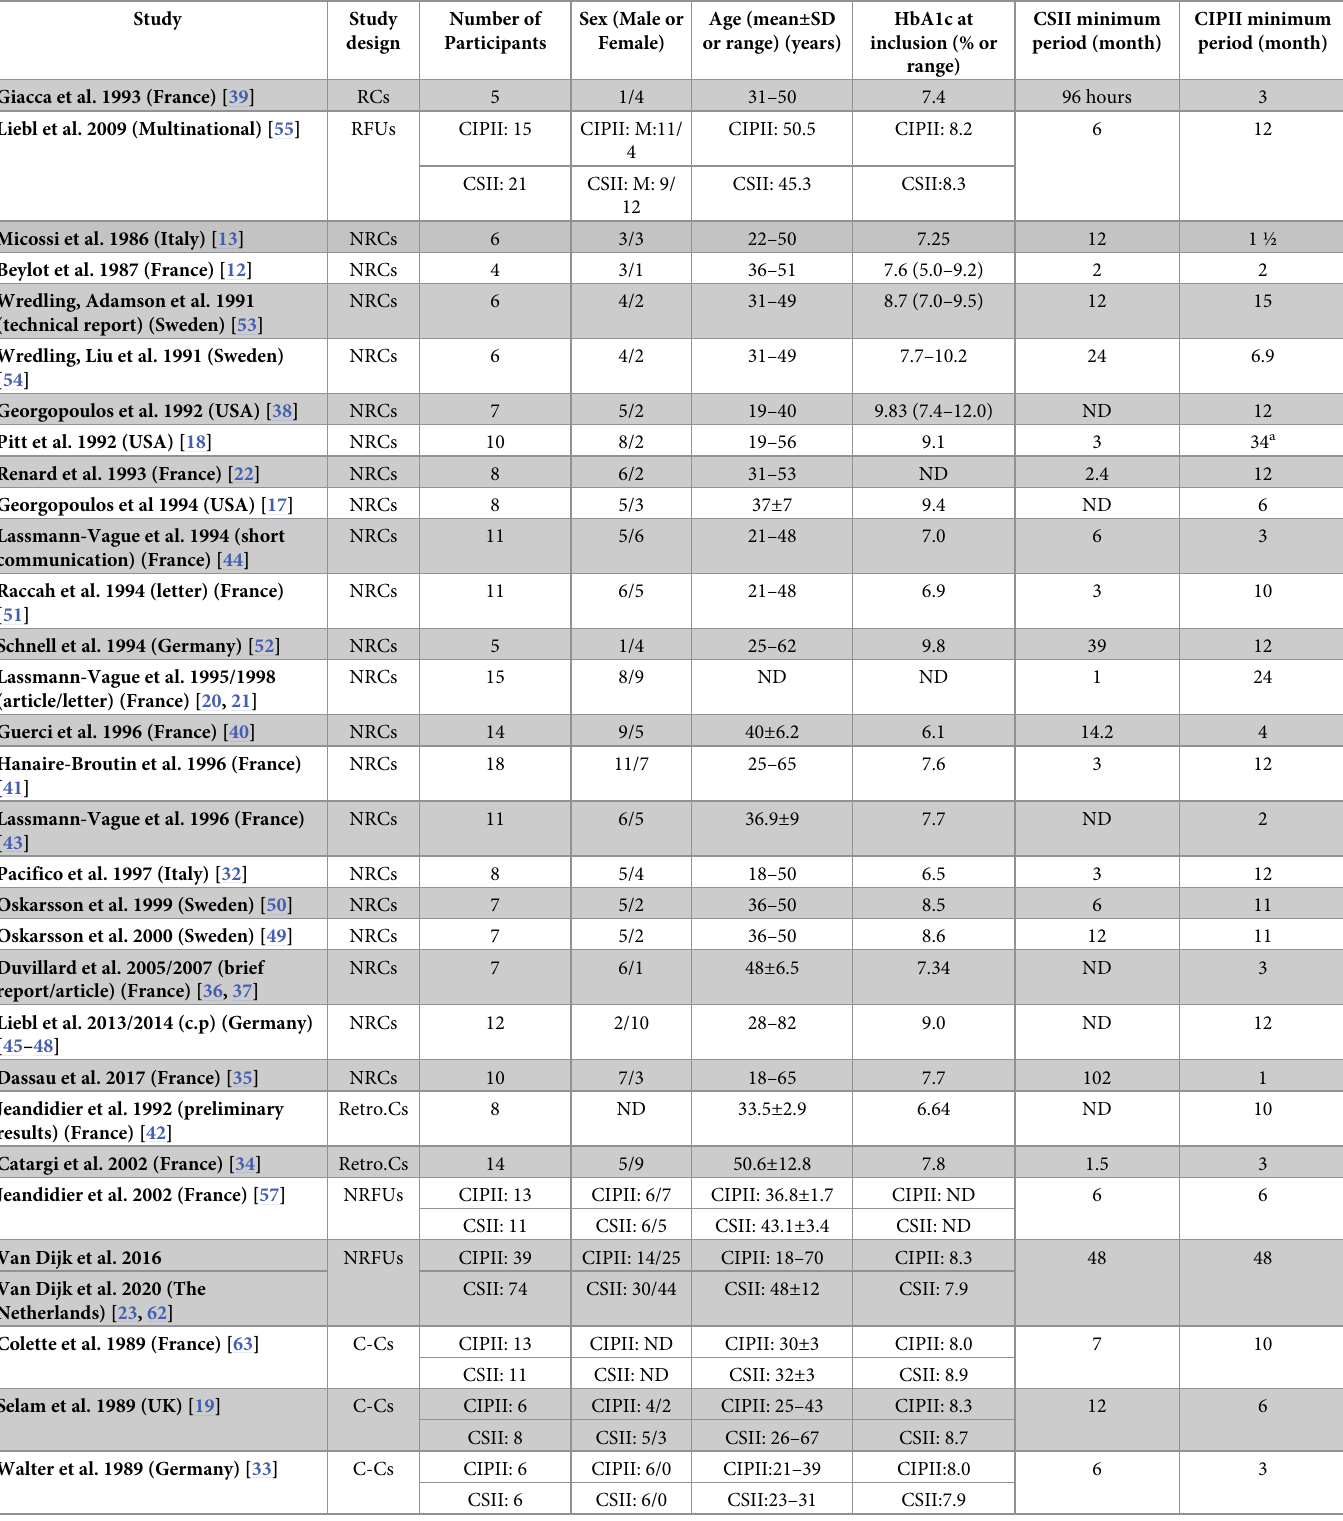
Table 1. Characteristics of studies included in the systematic